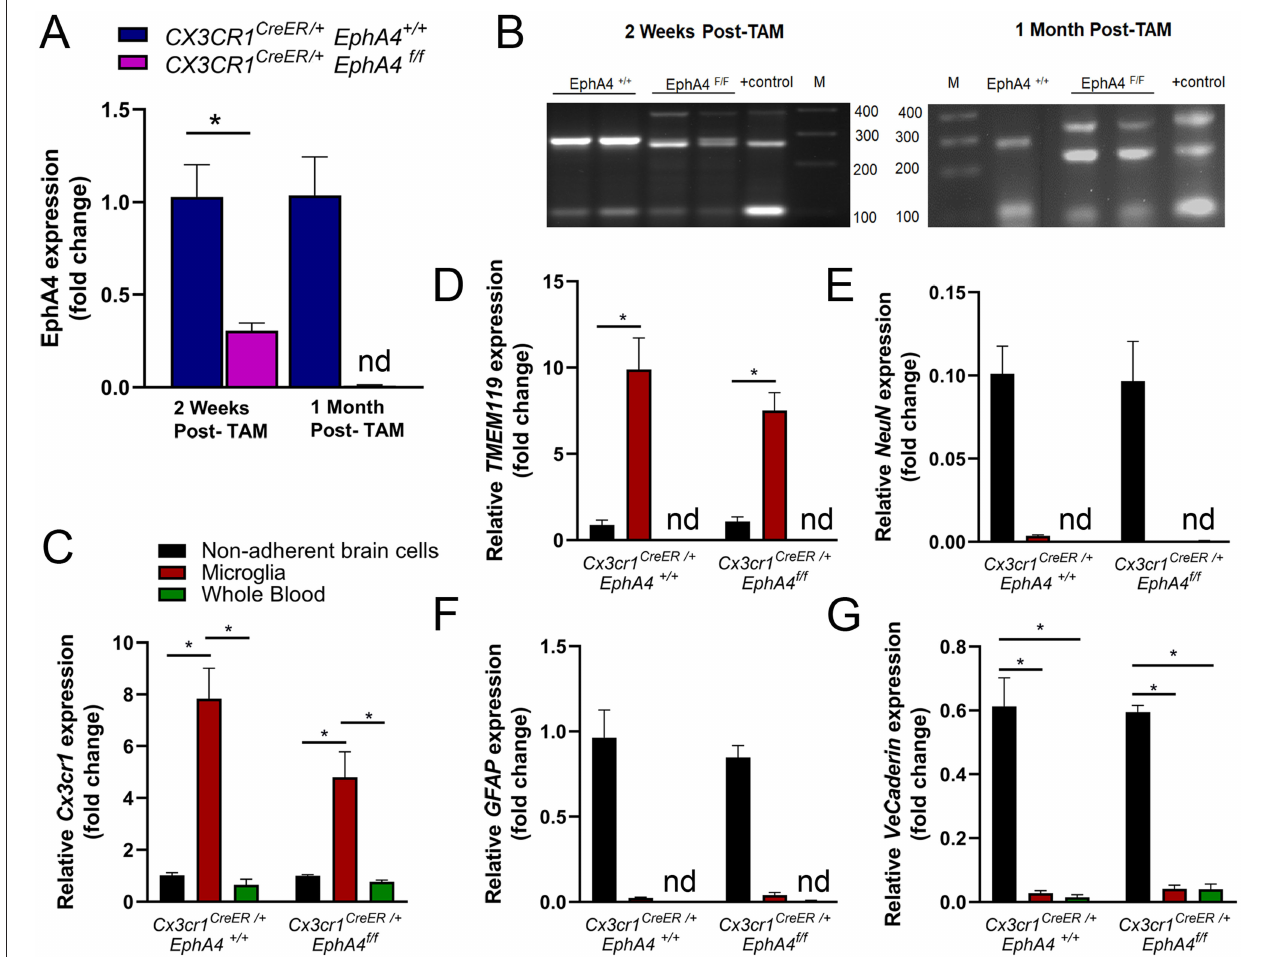
FIGURE 3 | Generation of microglia-specific EphA4-deficient mice. (A) Relative EphA4 expression in cortical microglia of naive Cx3cr1 CreER / + EphA4 + / + and Cx3cr1 CreER / + EphA4 f / f was measured at 2 weeks and 1-month post tamoxifen (TAM) injection using qRT-PCR. (B) PCR amplification of EphA4 − WT allele (286 bp), loxP-flanked EphA4 allele (390 bp), EphA4-excised allele (250 bp), and Cre (100 bp) in the DNA extracted from Cx3cr1 CreER / + EphA4 + / + and Cx3cr1 CreER / + EphA4 f / f microglia at 2 weeks and at 1-month post-tamoxifen injection. Positive ( + ) control showing loxP-flanked EphA4 allele (390 bp), EphA4-excised allele (250 bp), and Cre (100 bp). M = 100 bp low-scale DNA ladder. (C-G ) qRT-PCR analysis for microglial genes ( Cx3cr1 , C and TMEM119 , D ), neuronal gene ( NeuN , E ), astrocyte gene ( GFAP , F ), and vascular endothelial gene ( VE-cadherin , G ) in isolated microglia, non-adherent remaining cortical cells, as well as whole blood collected from naïve Cx3cr1 CreER / + EphA4 + / + and Cx3cr1 CreER / + EphA4 f / f mice. N = 3–6, * p < 0.05, significant difference between the designated groups; nd, not